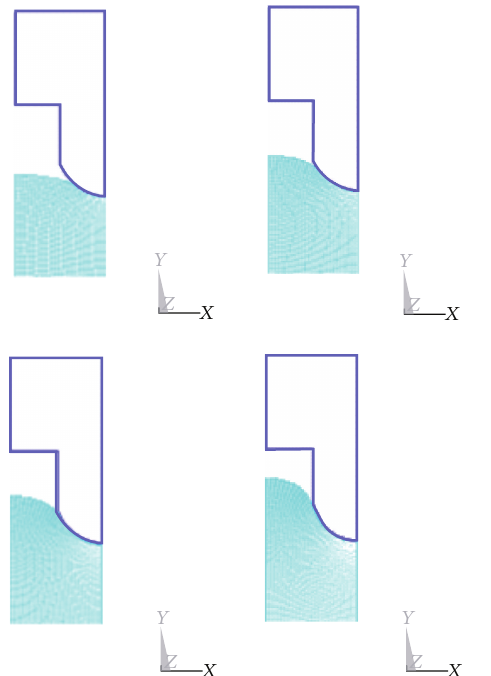
Figure 3: Polymer deformation at the decreased distances of 15, 30, 45, and 60 𝜇 m.